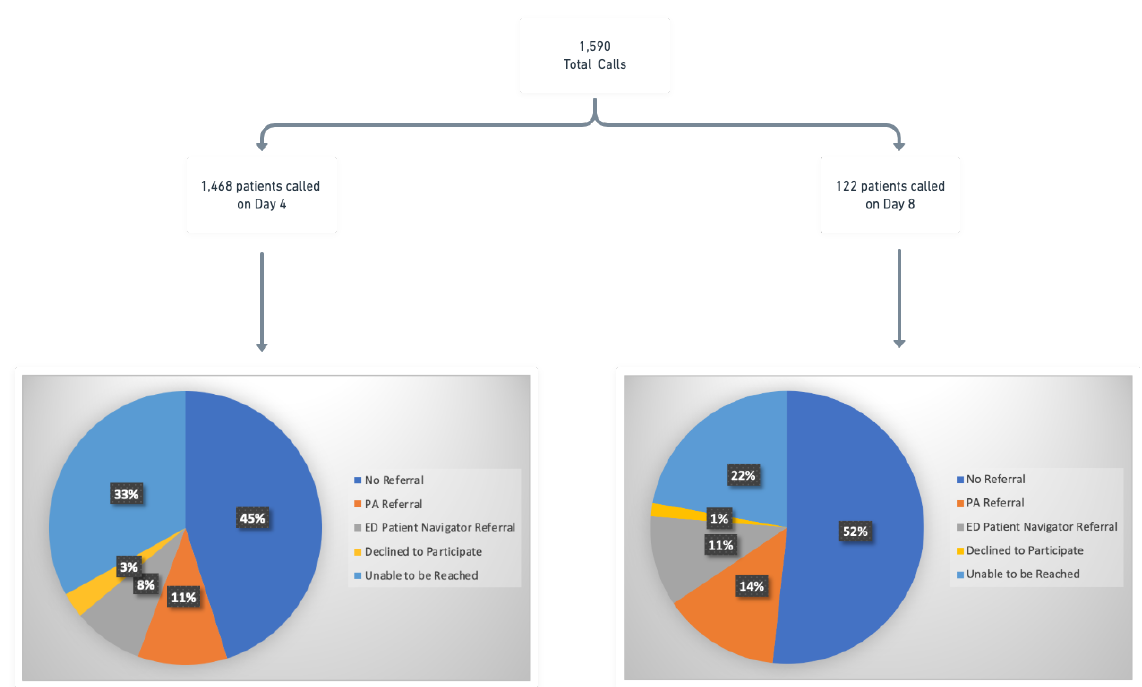
Figure 1. Outcome of day 4 and day 8 patient calls: April 24–June 29, 2020.